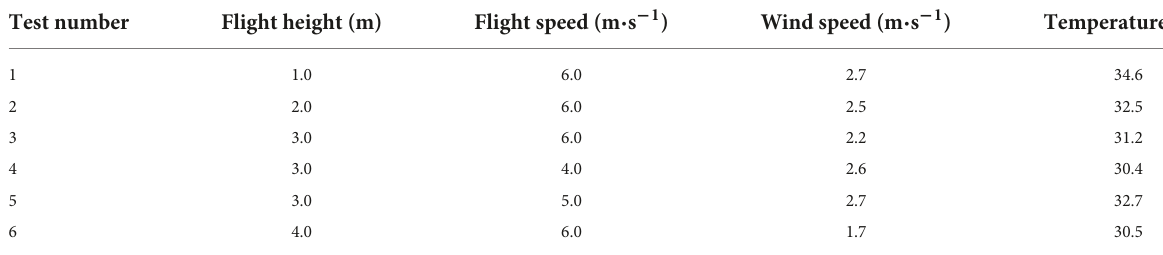
TABLE 2 Spray test and environmental